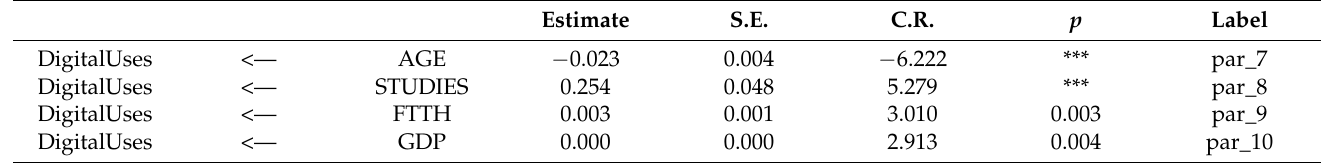
Table A13. Regression Weights: (Group number 1-Default model).